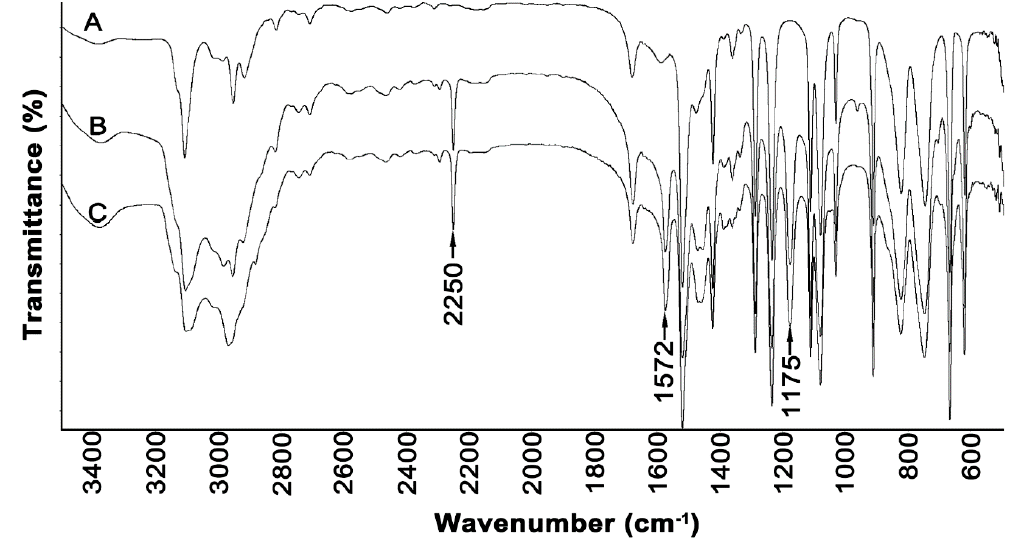
Figure 1. FTIR spectra of ( A ) methylimidazole, ( B ) [EMIM][Cl], and ( C ) [PMIM][Cl].